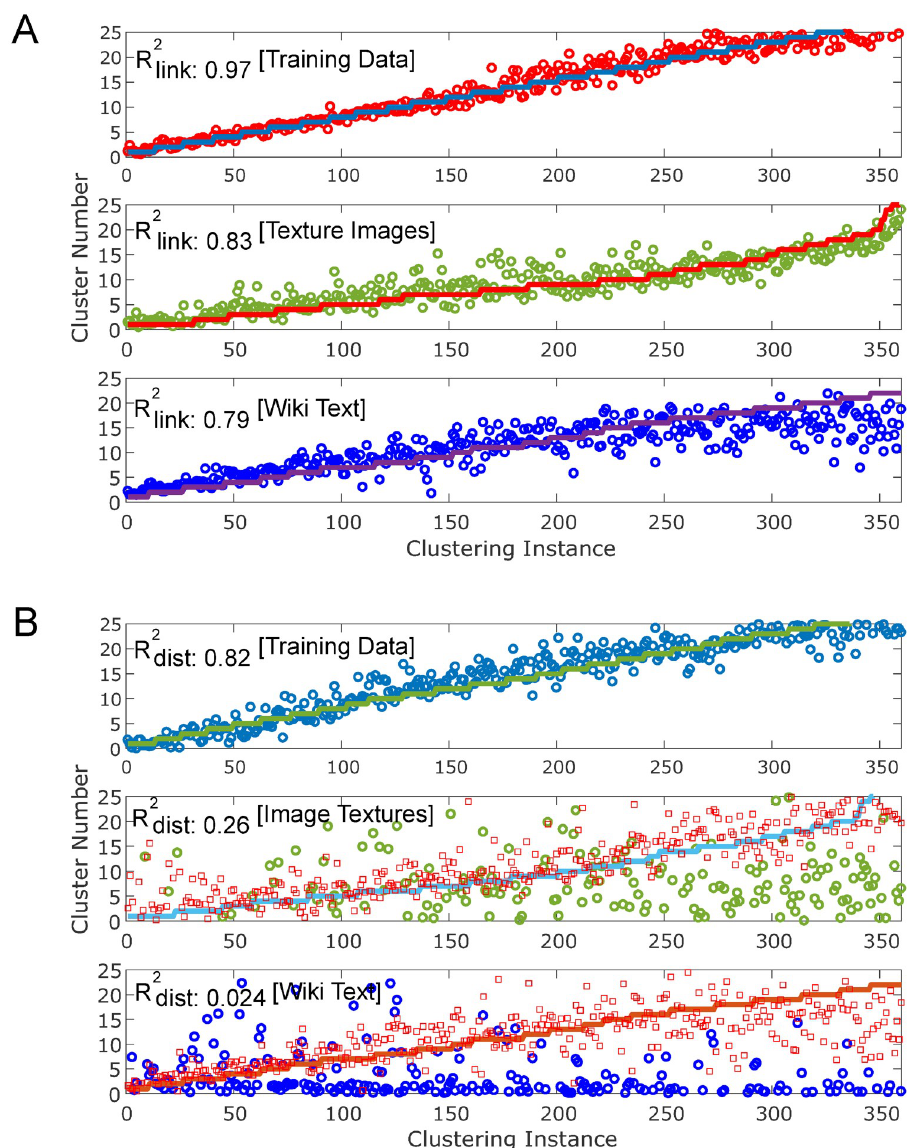
Fig 6. Estimation of cluster number by hierarchical linkage regression. (A) Results for cluster number estimation (inference) based on linkage hierarchy. Coefficients of determination ( r 2 ) are reported for each dataset. Top: fitted training set inferences (open circles) plotted against ground truth (solid stepped line); middle: image data inferences (open circles), plotted against ground truth (solid stepped line); bottom: Wiki text data inferences (open circles), plotted against ground truth (solid stepped line); note the underestimation of cluster number for text data at high cluster counts. Linkage type: complete; distance metric: L1 norm; histogram partitions: R = 40; embedding dimension: d E = 50. (B) Results for cluster number estimation based on distance (L1 norm). Plot of training set (top) and test set (middle: image; bottom: text) cluster number inferences versus ground truth (solid stepped line), comparing distance- only (open circle) vs. linkage hierarchy (open red square) regression models, matched to have same input vector size and network architecture. The distance-only regression model fits the training data well, but is unable to generalize to image data or text data. Coefficients of determination ( r 2 ) are reported for the distance model